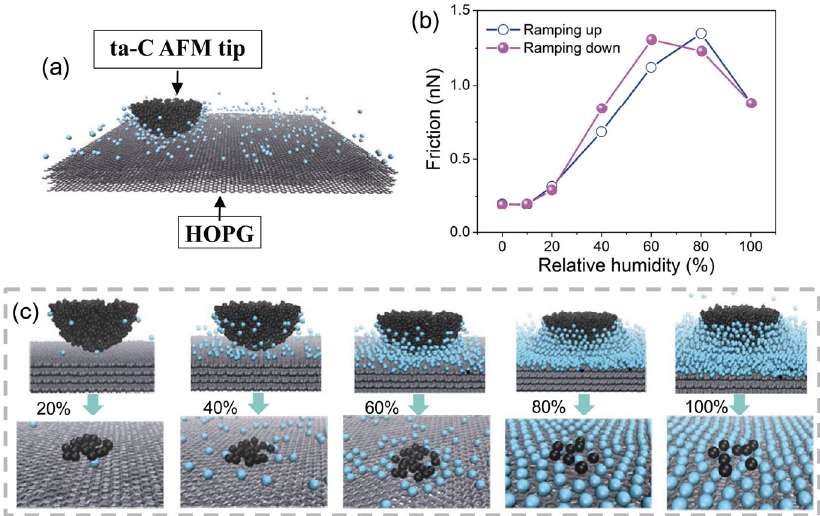
Fig. 9 RH-dependent friction and contact state between a ta-C coated AFM tip and HOPG. (a) Schematic of GCMC simulations of ta-C coated AFM tip sliding on model graphite surface; (b) friction obtained from GCMC simulations; (c) effect of water condensation on contact of amorphous carbon micro-sphere and graphite substrate. Upper: contact models at different RH values in MD simulation. Bottom: change in amount of contacted atoms with increase in RH. Gray ball: carbon atom of HOPG; cyan ball: water molecule; black ball: carbon atom of AFM tip. Reproduced with permission from Ref. [12], © American Physical Society